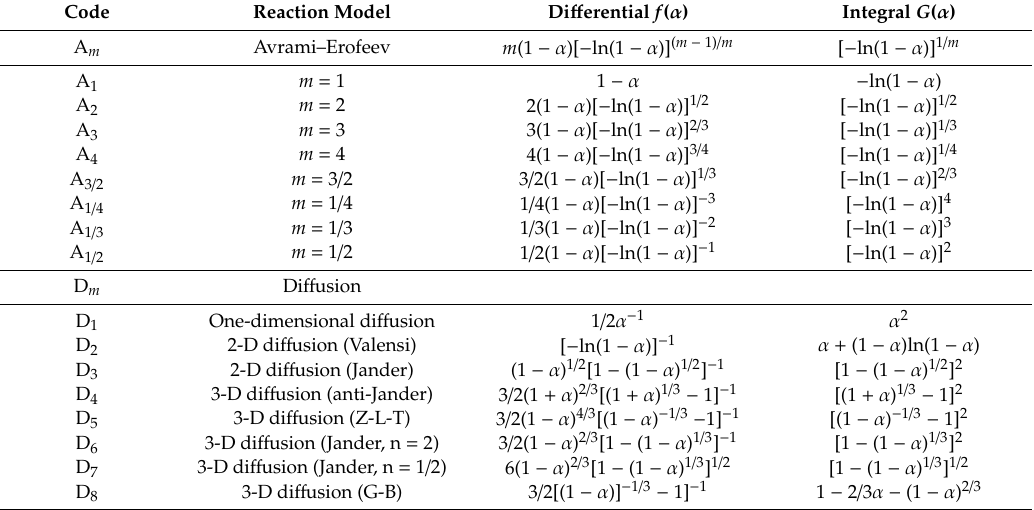
Table 3. Di ff erential and integral expressions of common reaction mechanism